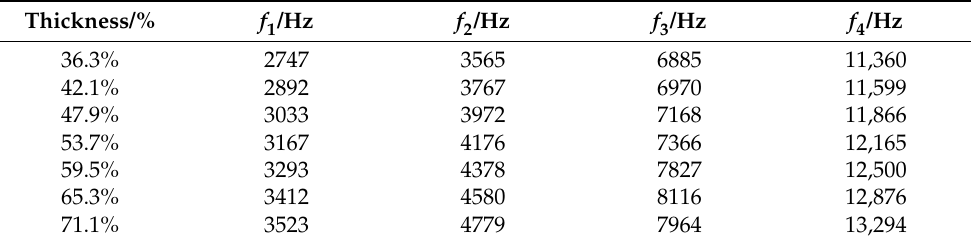
Table 8. TWR characteristics of gears with different vibration at different thickness of spoke plate.